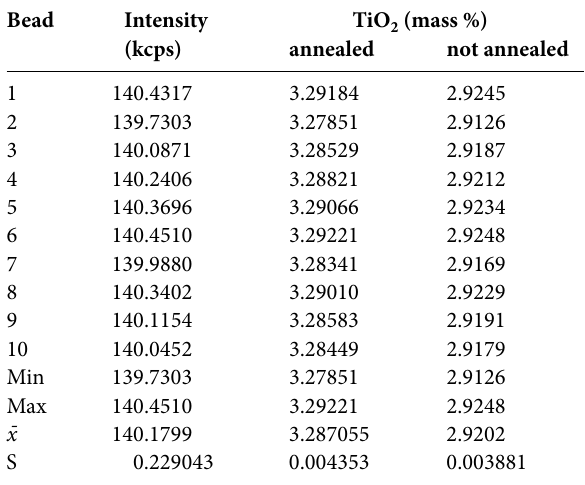
Table 10. The content of TiO 2 in one bead of “Grčka” bauxite calcu- lated using the XRF method (by pressing) Number Intensity